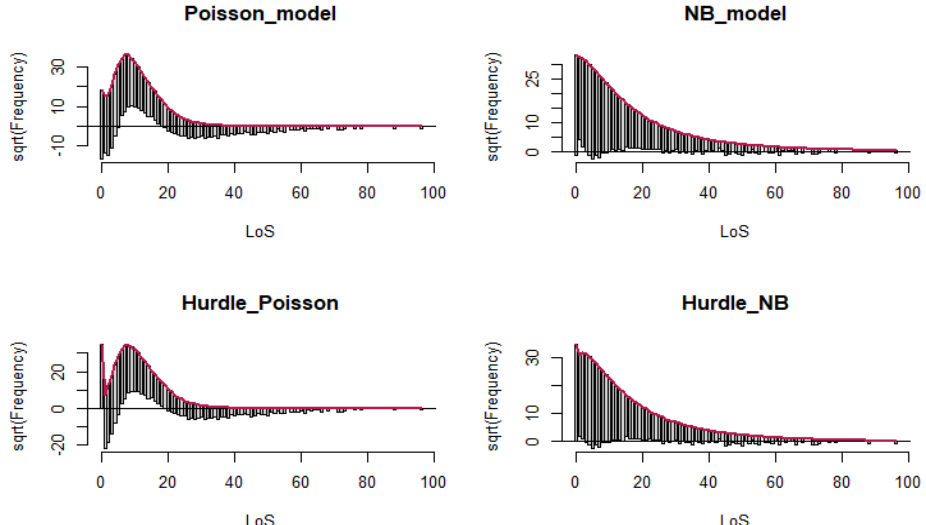
Figure 5. Rootogram